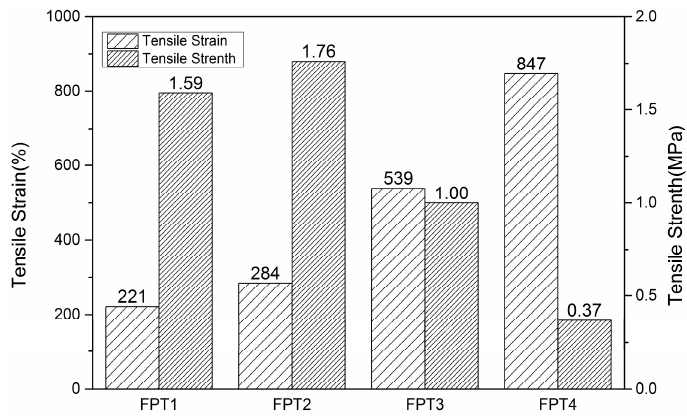
Figure 6. The effect of different chain-extension ratios on tensile strain and strength of films.